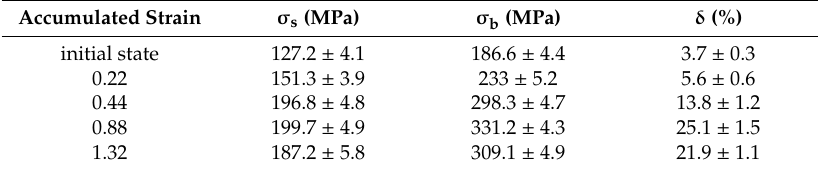
Figure 8. Mechanical properties of AZ31 alloys HSRBFed to different accumulated strains.